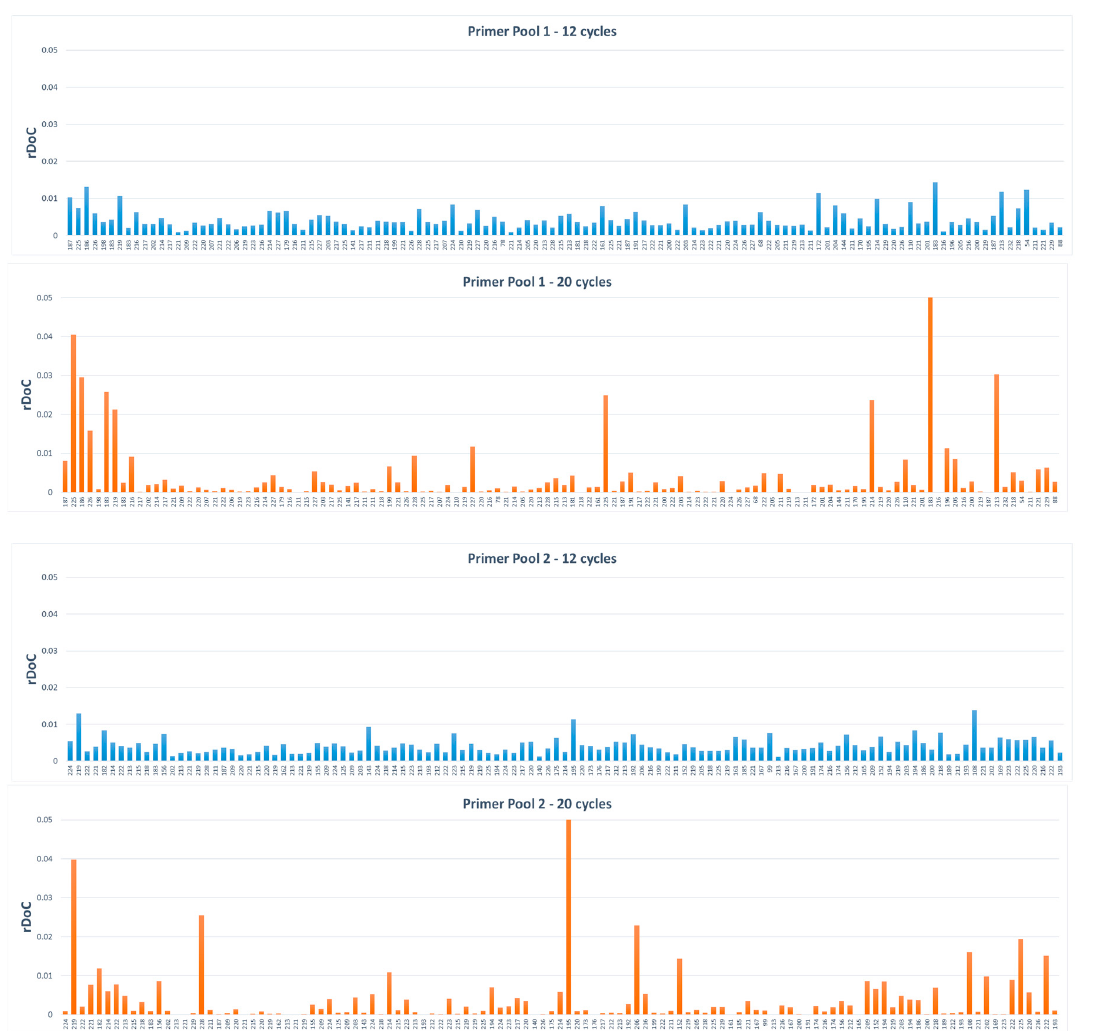
Figure 2. Mean relative depth of coverage (rDoC) distribution observed in libraries from isolates amplified with 12 and 20 PCR cycles. For easier viewing, the distributions are separated into two plots relative to the different primer pools.